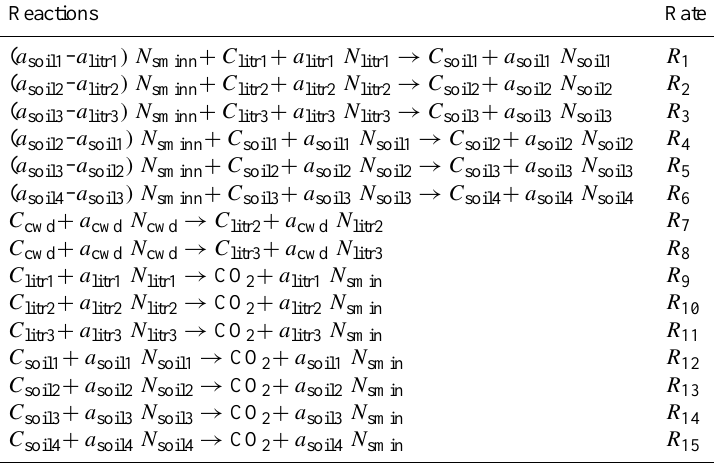
Table 2. CLM-CN decomposition cascade model.